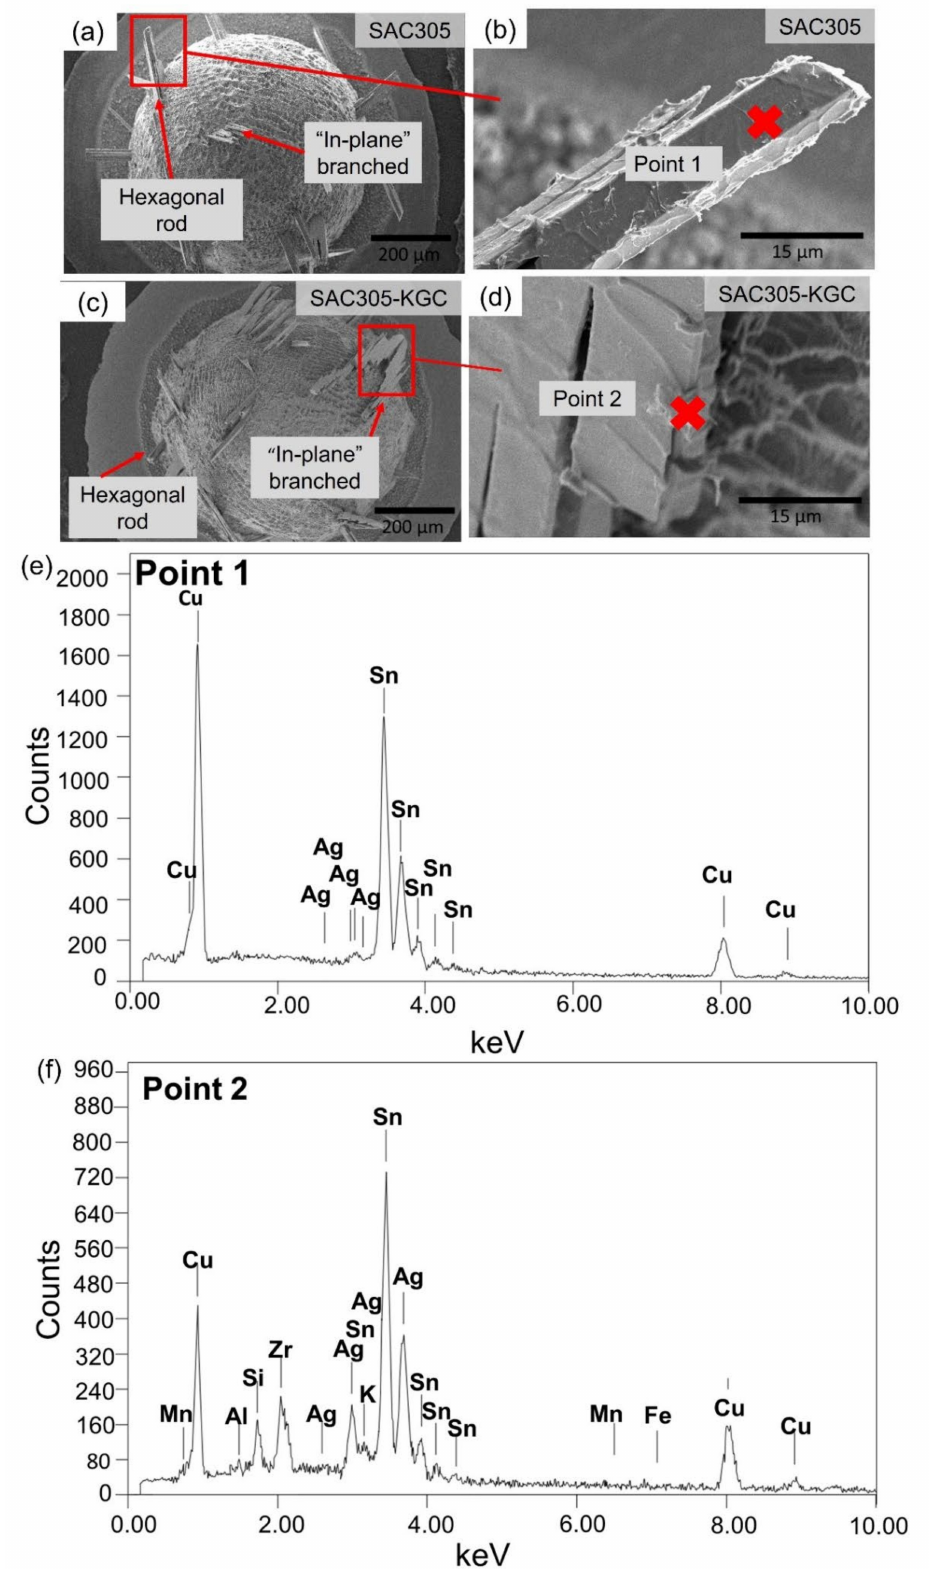
Figure 10. Top-down view of primary IMC in the bulk solder ( a ) Low magnification of SAC305, ( b ) Low magnification of SAC305-KGC, ( c ) High magnification of SAC305, ( d ) High magnification of SAC305-KGC. EDX point analysis at primary IMC in ( e ) SAC305, and ( f )